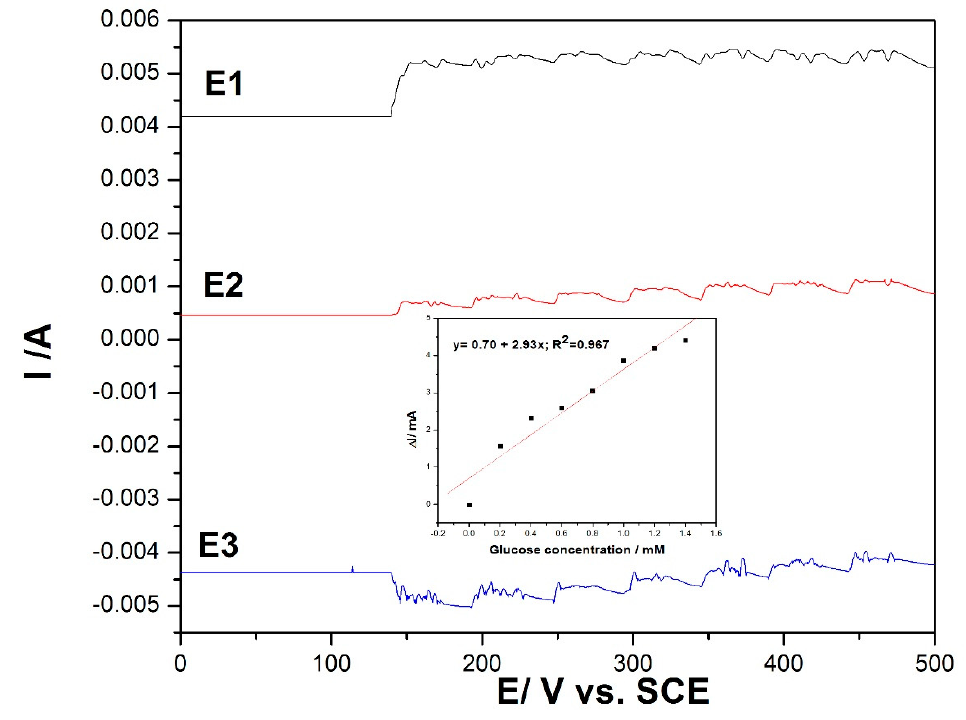
Figure 7. Multiple pulse amperometry (MPA) recordings for three levels of the potential pulses of + 1.25 V / SCE for 0.1 s (E1), + 0.6 V / SCE for 0.05 s (E2), and − 0.5 V / SCE for 0.1 s (E3) at the MWCNT-CuBTC composite electrode in 0.1 M of NaOH supporting electrolyte and in the presence of various glucose concentrations in the range of 0.2–1.4 mM. The inset shows the calibration plots of the current recorded at + 0.6 V / SCE versus the glucose concentration.